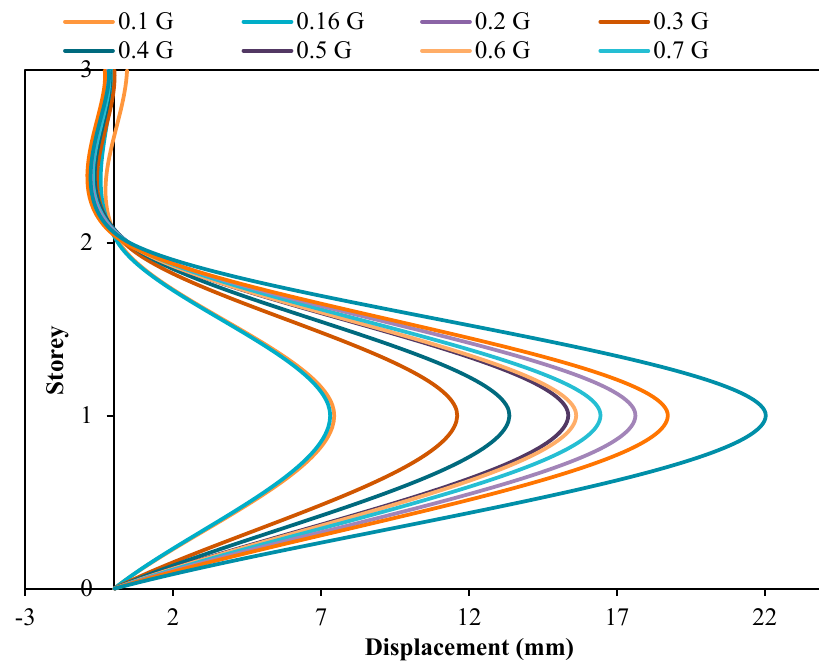
Figure 12. Inter-storey drift of structure with dampers.